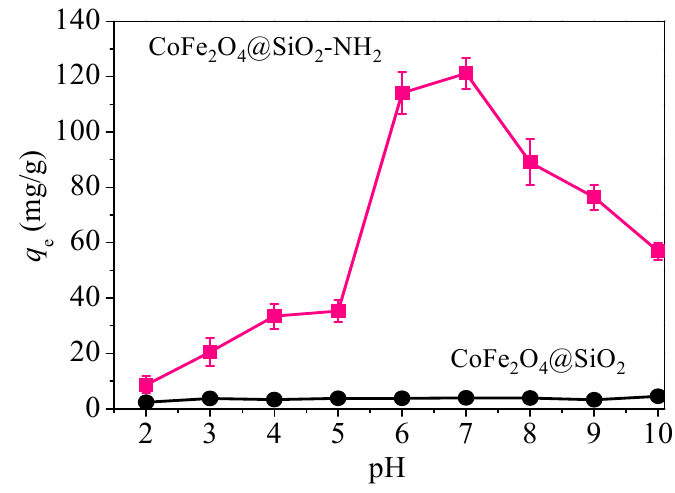
Figure 9. Effects of pH on the adsorption of Hg(II). Conditions: dosage of 0.1 g/L, C 0 = 20 mg/L, t = 12 h and T = 298 K.